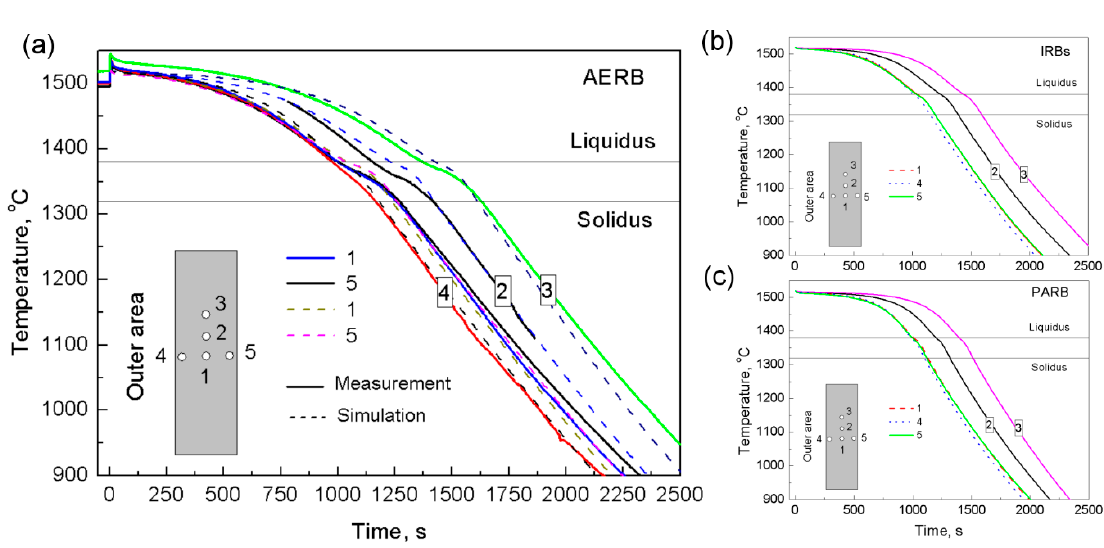
Figure 3. Comparison of experimental ( a ) and predicted ( a – c ) cooling curves at test points of casting for the process with the application of ( a ) ring-shaped adjusted external radiation baffle (AERB); ( b ) inner radiation baffles (IRBs); ( c ) perfectly adjusted radiation baffle (PARB).